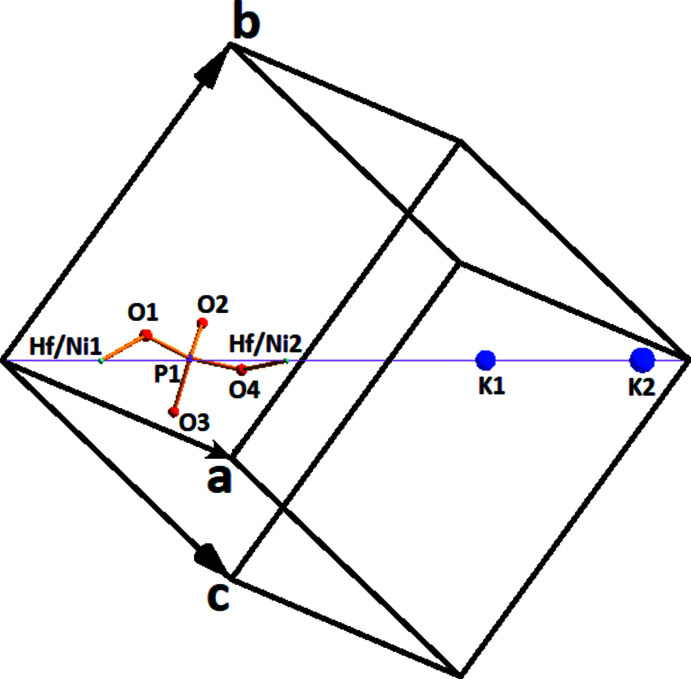
A view of the asymmetric unit of K2Ni0.5Hf1.5(PO4)3, with displacement spheres drawn at the 50% probability level.